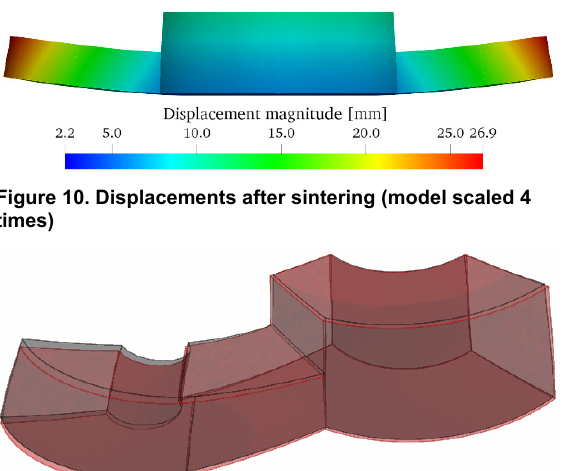
Figure 11. Final sample shapes (red: non-uniform tempe- rature, black: uniform temperature; displacement scale factor x4)